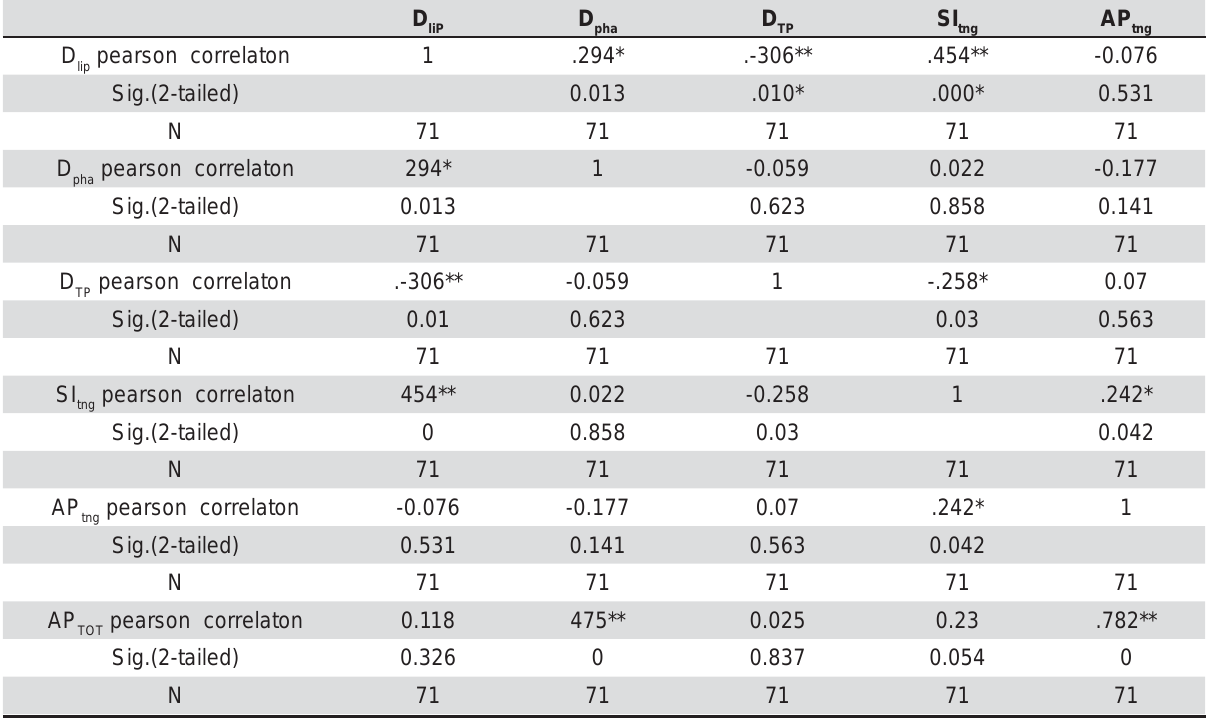
, D , D , SI , and AP lip pha TP tng